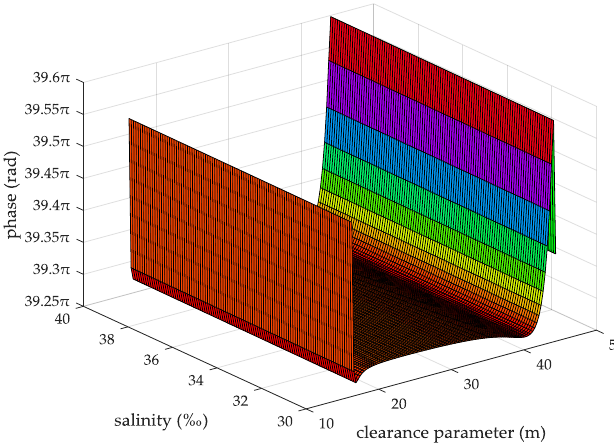
Figure 11. Figure 11. The ASFs of the AIS received signal changing with the sea salinity and the clearance parameter.